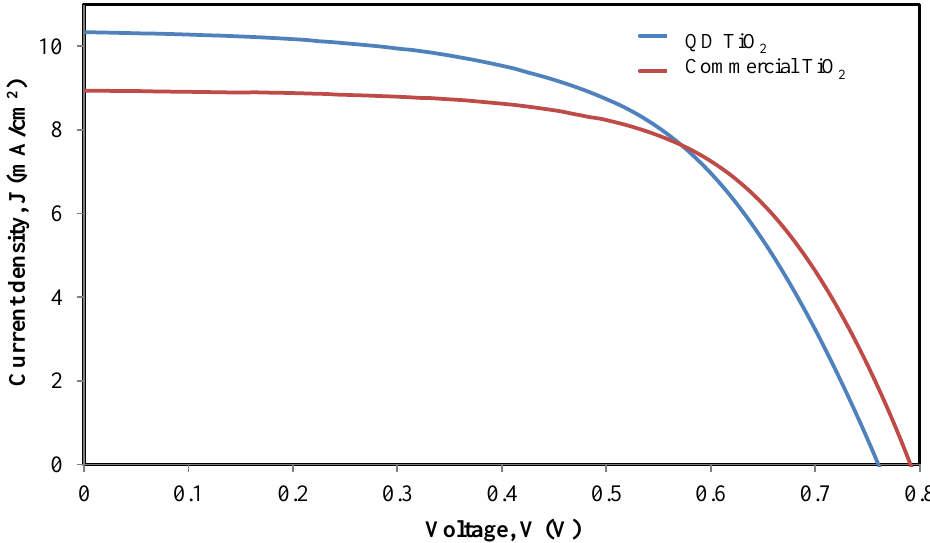
Figure 5. Absorbance spectra of the desorbed dye solution of the QD TiO 2 and commercial TiO 2 nanoparticles.